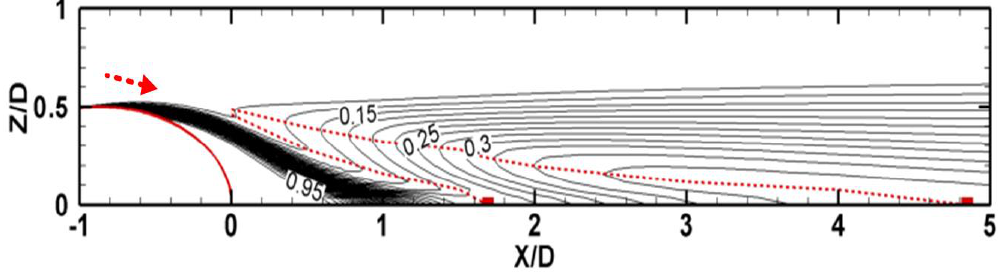
Figure 11. Effectiveness contours on the test plate.